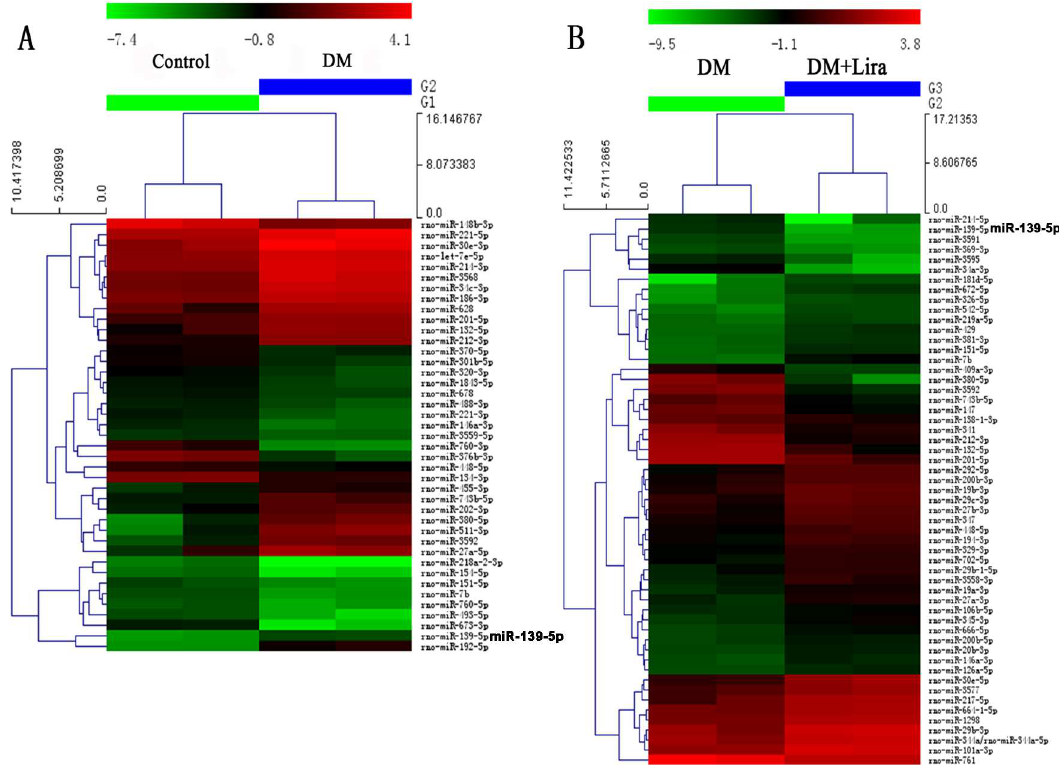
Fig 4. Cluster analysis of the microRNA expression levels in rat pancreatic tissues between the different groups. (A) DM group vs. control group; (B) DM group vs. DM + liraglutide group). Diabeticrats were dividedinto two groups, administered without (DM group) or with liraglutide(DM + Lira group) at a dose of 200 μ g/kg/d. SD rats of control group were fed with normal chew and receivedsubcutaneous injectionof saline.